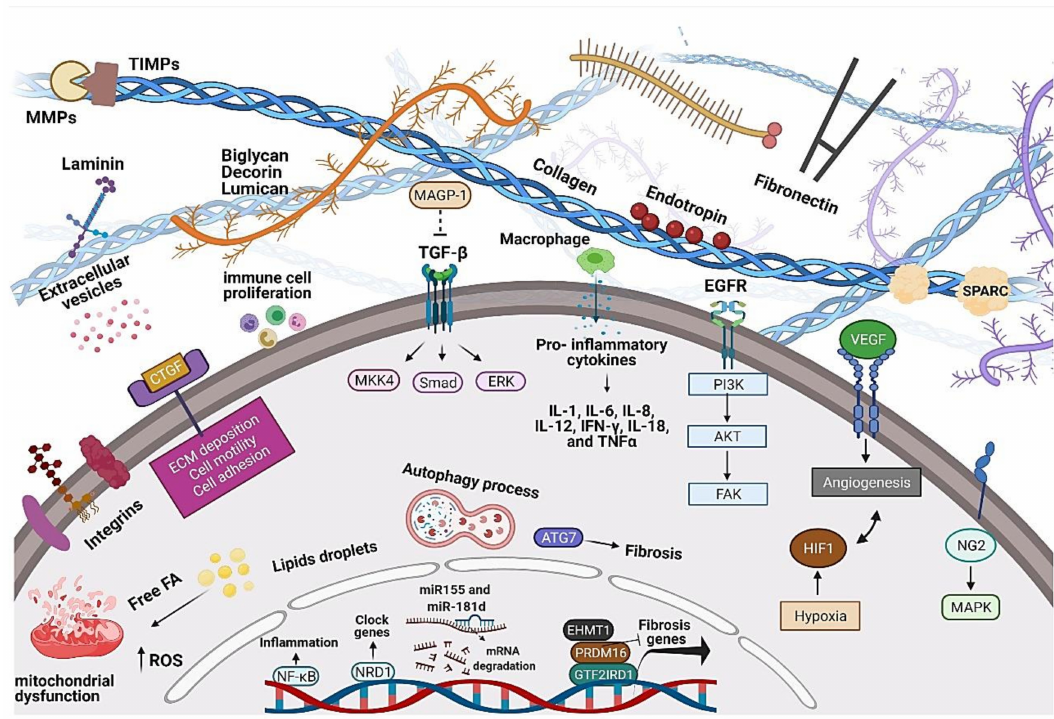
Figure 4. Overview of players and molecular pathways that mediate the progression of adipose tissue fibrosis. Extracellular compartment: collagen, laminin, fibronectin, glycosaminoglycans, pro- teoglycans (Biglycan, Decorin, Lumican), integrins, growth factors (Tgf- β , Ctgf, and Vegf), enzymes (Mmps and Timps), and vesicles. Intracellular compartment: increase in gene and protein expression linked to ECM components, adipogenesis, cytoskeleton, inflammation (pro-inflammatory cytokines and Nf κ B), angiogenesis, hypoxia (Hif1), oxidative stress (ROS), clock (Nrd1), and autophagy